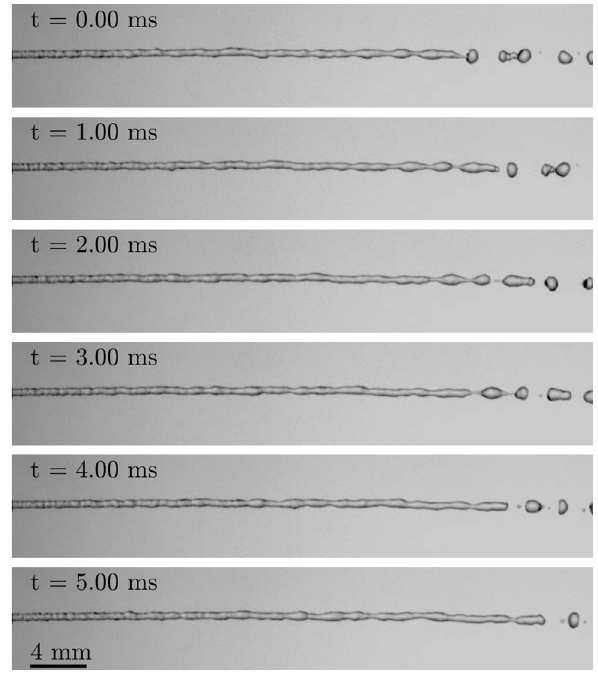
Figure 3. Example free liquid nitrogen jet formed at the needle outlet during device operation with p l ≈ 1.6 bar and p g ≈ 0.8 bar. The liquid leaves the needle with approximately v jet = 2.97 m/s resulting in a mass flow of approximately ˙ m = 0.47 g/s and a device efficiency of η ≈ 60%